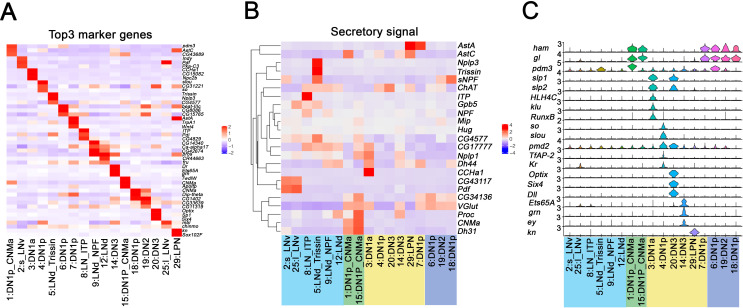
Enriched transcripts in identified clock neuron clusters.(A) Heatmap showing the enriched marker genes expression in each cluster. (B) Heatmap showing the enriched secretory gene expression in each cluster. (C) Violin plot showing the expression of DN1p- and LPN-enriched transcription factors. Light:dark (LD) and constant darkness (DD) data are plotted together, the y axis represents log normalized gene expression level.